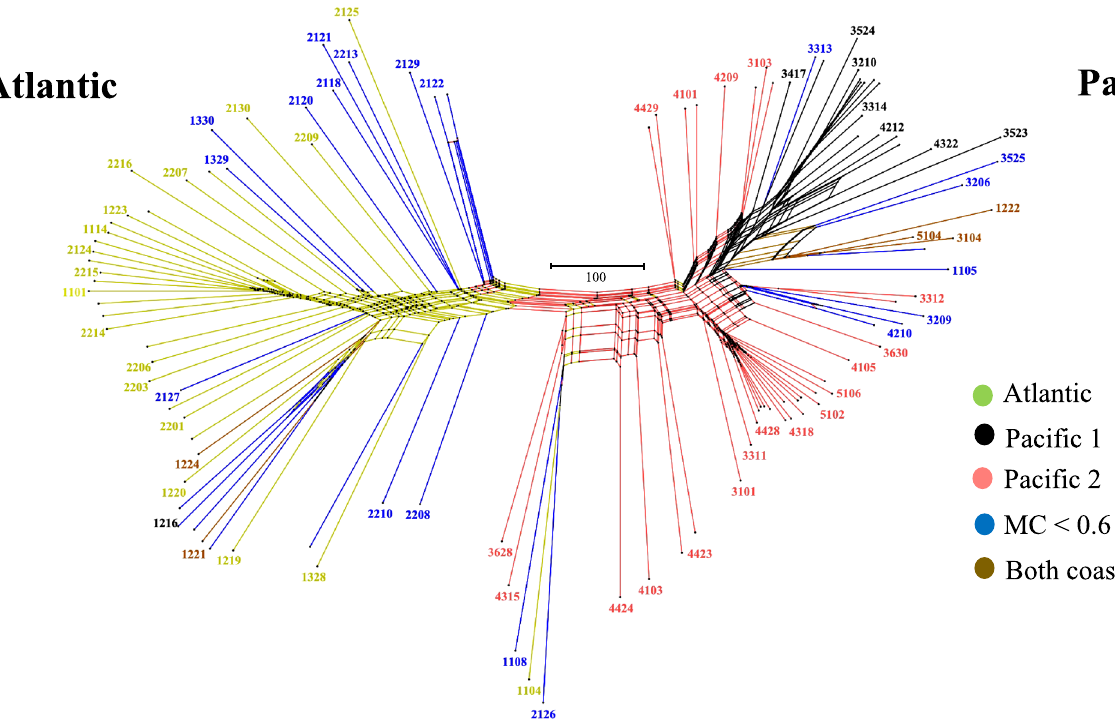
Figure 6. NeighborNet network shows reticulate genetic relationship between accessions. Color coding corresponds to the STRU CTU RE clusters of Fig. 3. A scale is shown